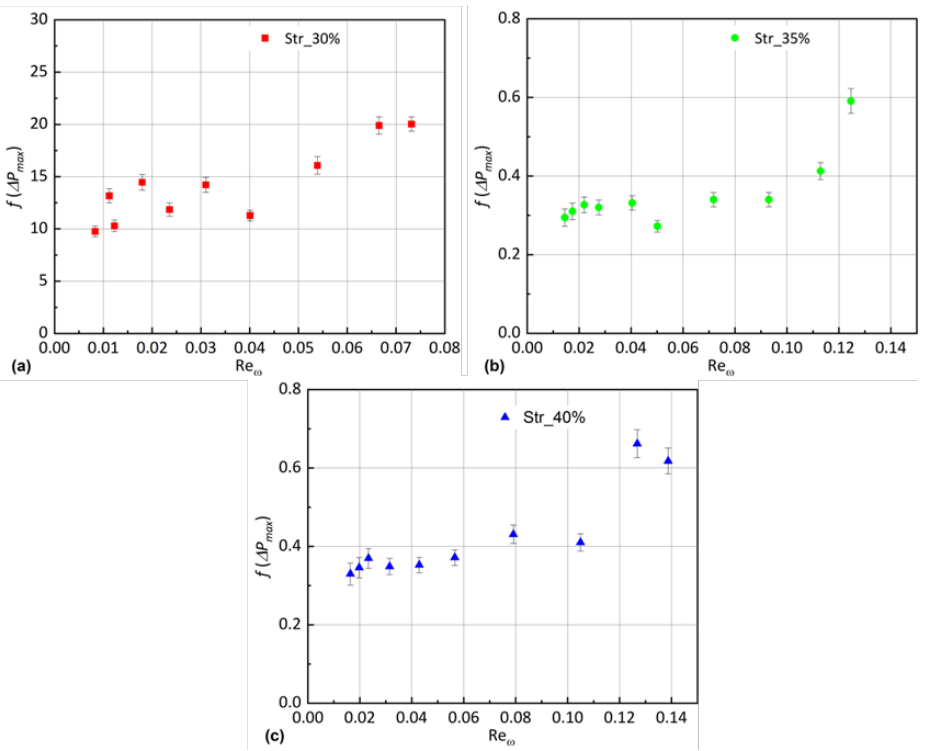
Figure 13. Evolution of friction factor at maximum pressure drop of regenerator (( a ): Str_30%, ( b ): Str_35%, ( c ): Str_40%. L 1 = 60 mm, C 1 = 64.4 mm) versus kinetic Reynolds number Re ω .